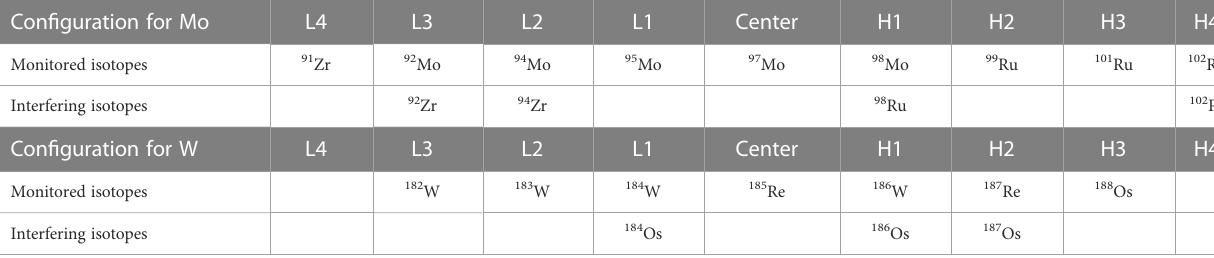
TABLE 4 Cup con fi gurations of Neptune plus for Mo and W